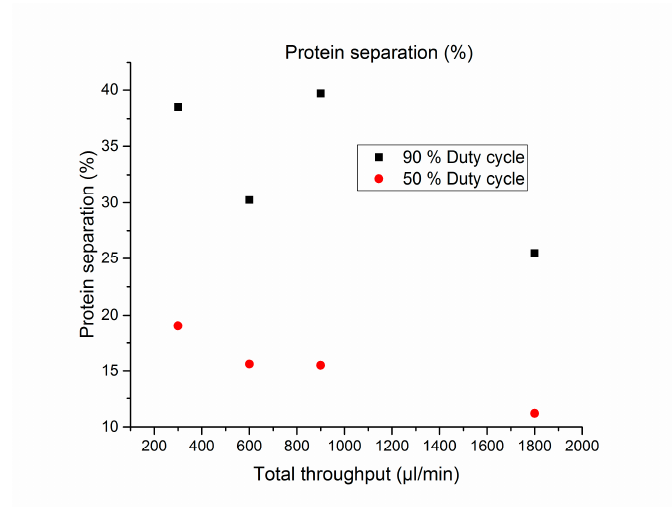
Figure 4. Separation test. Protein separation performances depends on the duty cycle of the square wave signal and on the flow